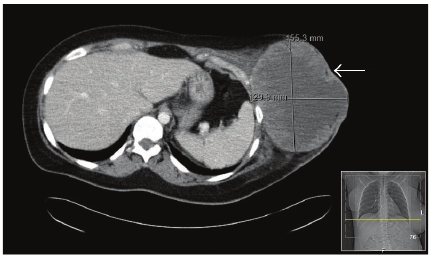
Figure 1: Arrow pointing to the soft tissue mass in the left lateral chest wall with its